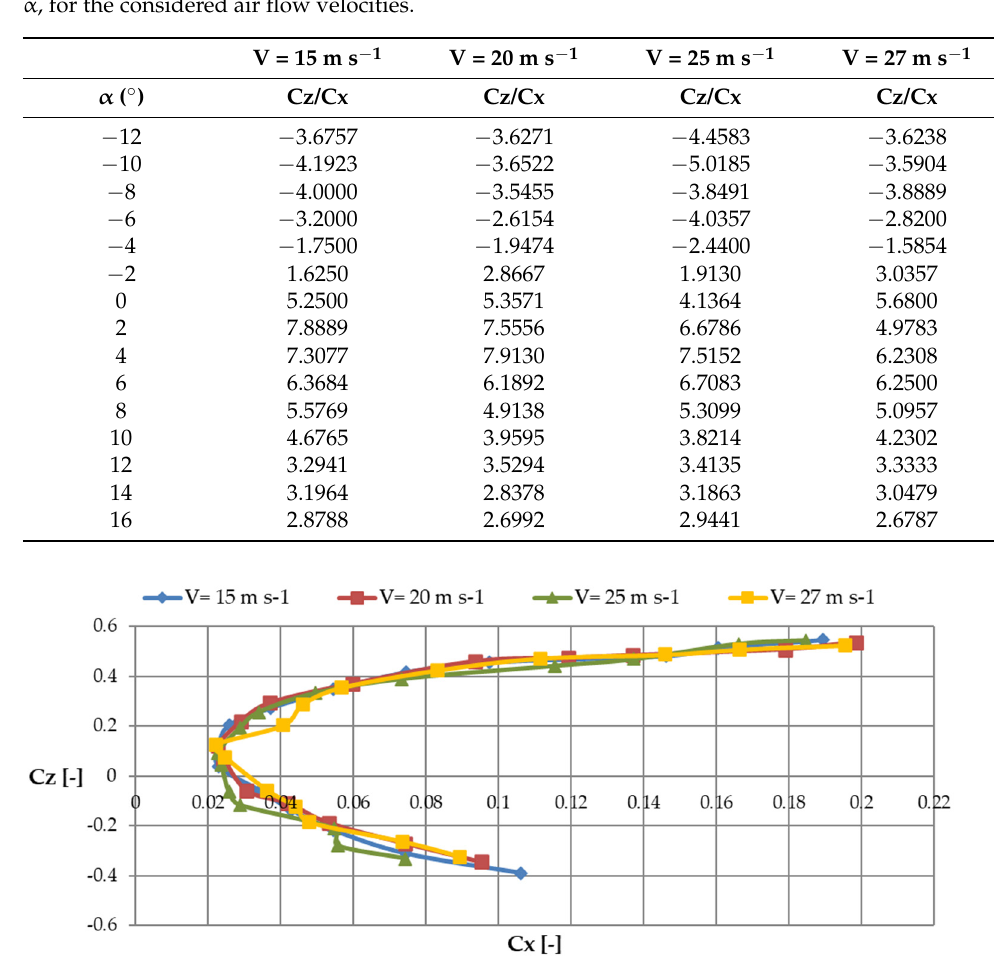
Figure 13. Summary plot of drag force coefficient, Cx, for positive and negative angles of attack, α , for all airflow speeds tested. Table 5. Computed values of the aerodynamic efficiency, K, for positive and negative angles of attack, α , for the considered air flow velocities.